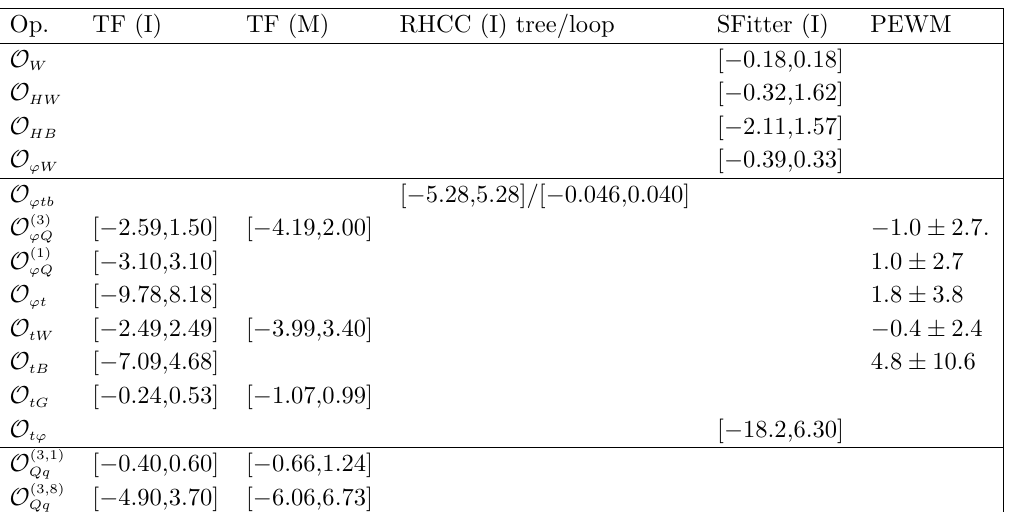
Table 3 . Limits on operator coe(cid:14)cients, from the TopFitter (TF) Collaboration (individual (I) and marginalised (M)) [56] supplemented with constraints on c (3 ; 8) ref. [63], right-handed charged currents (RHCC, individual) [57], the SFitter group (individual) [58], and precision electroweak measurements [72] (marginalized over = ). (cid:3) = 1 TeV is C (3) C (1) ’Q ’Q (cid:0)